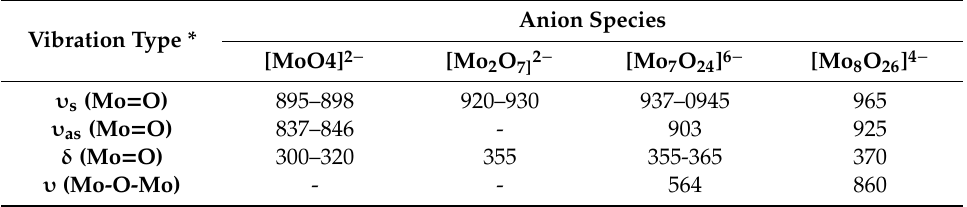
Table 8. Raman frequencies (cm − 1 ) for Mo oxyanions species. Data taken from Refs.